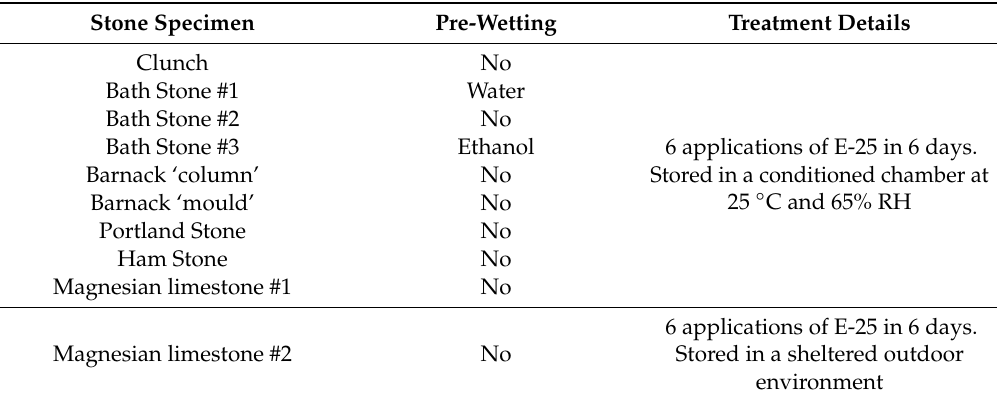
Table 1. Nanolime treatments applied to the stone